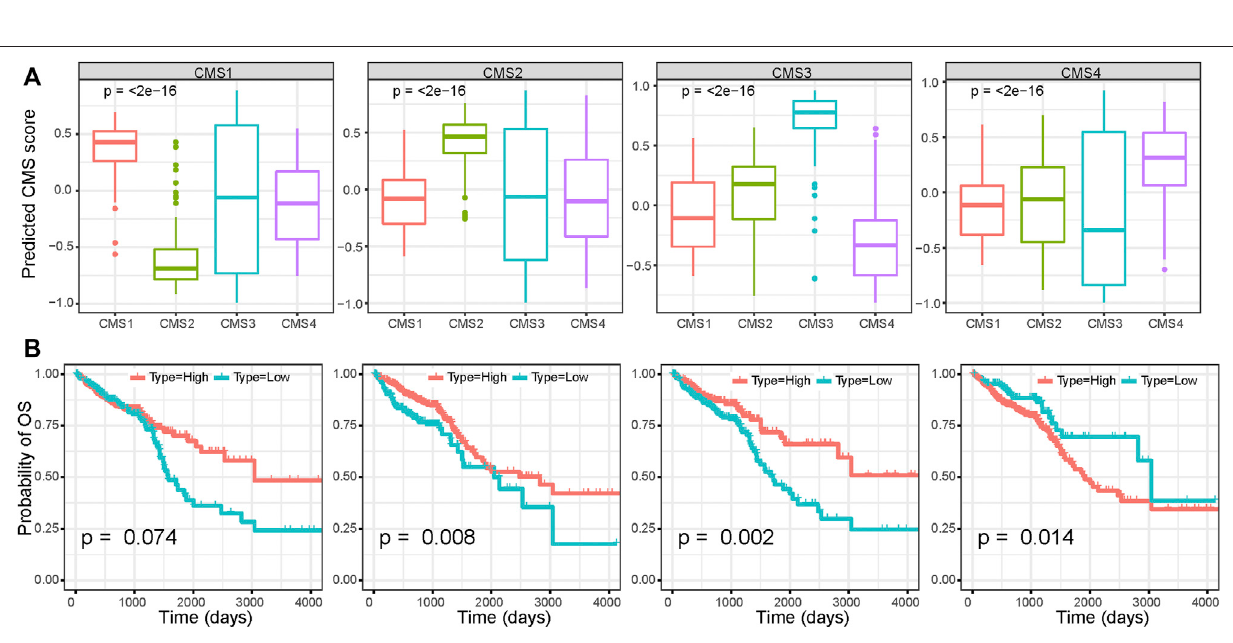
comparison with normal cells. The dysregulation of ERG performs diverse roles by regulating the expression of different downstream genes, which could be associated with the heterogeneity of the gene regulatory networks and the